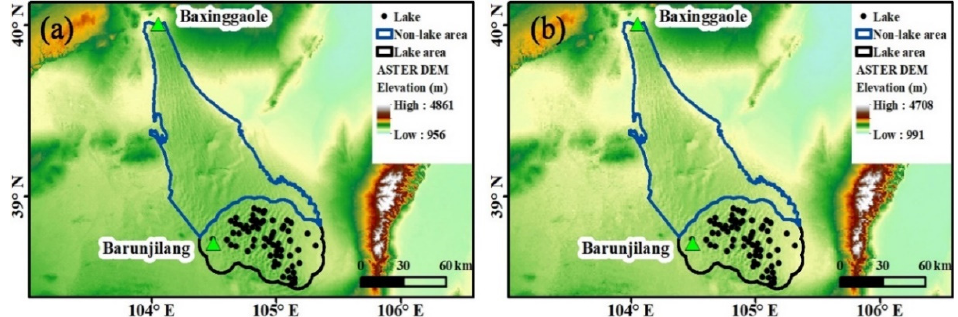
Figure 5. Elevation of the area as derived from ASTER data ( a ), resampled ASTER image of area ( b ). When the elevation and latitude of LST in the lake and non-lake areas are revised, both LST and elevation shall be at the same spatial resolution. The MODIS and ASTER products have different spatial resolutions; therefore, the elevation data and LST data were resampled to a resolution of 1000 m using the nearest-neighbor sampling approach in ArcMap 10.5 software. Once registered to the same projection system with the same spatial resolution, it is possible to retrieve corresponding values of both LST and elevation for each pixel. Figure 5b shows the resampled ASTER image of the area. After resampling, the highest elevation reduced to 4708 m from 4861 m, and lowest elevation increased to 991 m from 956 m due to averaging of neighborhood pixels.